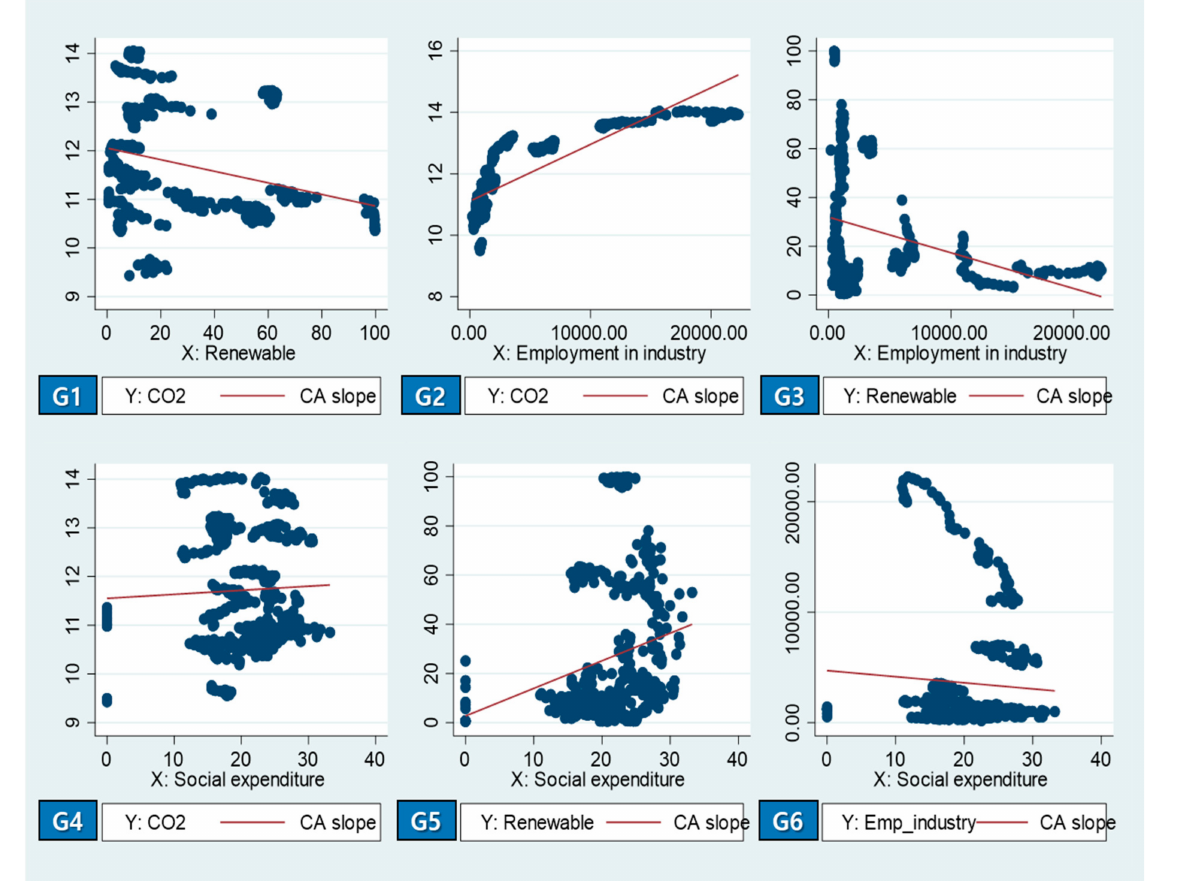
Figure 3. Correlation analysis results of the relevant variables (1987–2013). Table 2. Correlation analysis results of the relevant variables (1987–2013). CO